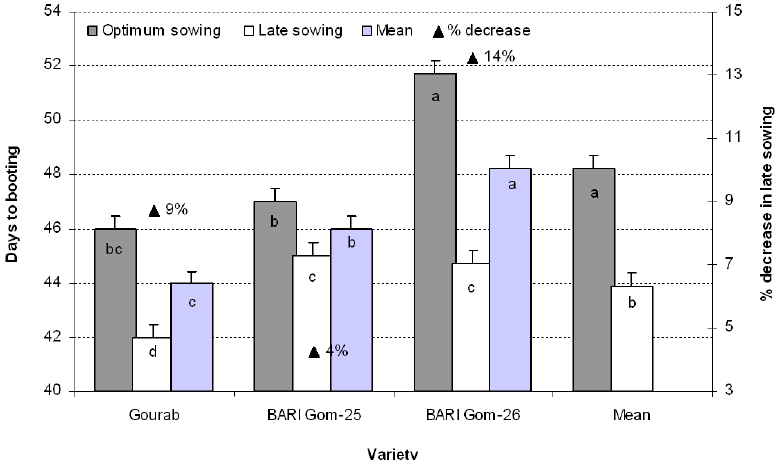
Fig. 3. Days passed to booting of 3 wheat varieties when sown under optimum and very late conditions. Mean (±SD) was calculated from three replicates for each treat- ment. Bars with different letters are significantly different at p ≤ 0.05 (LSD